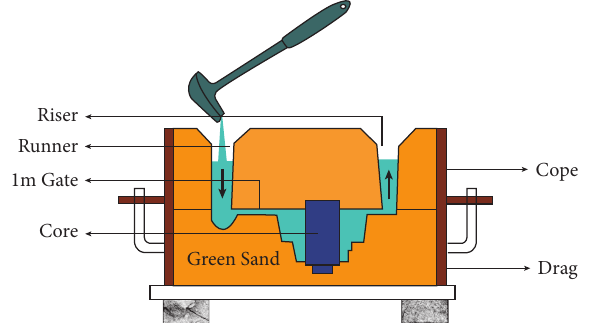
Figure 1: Schematic representation of sand casting process.